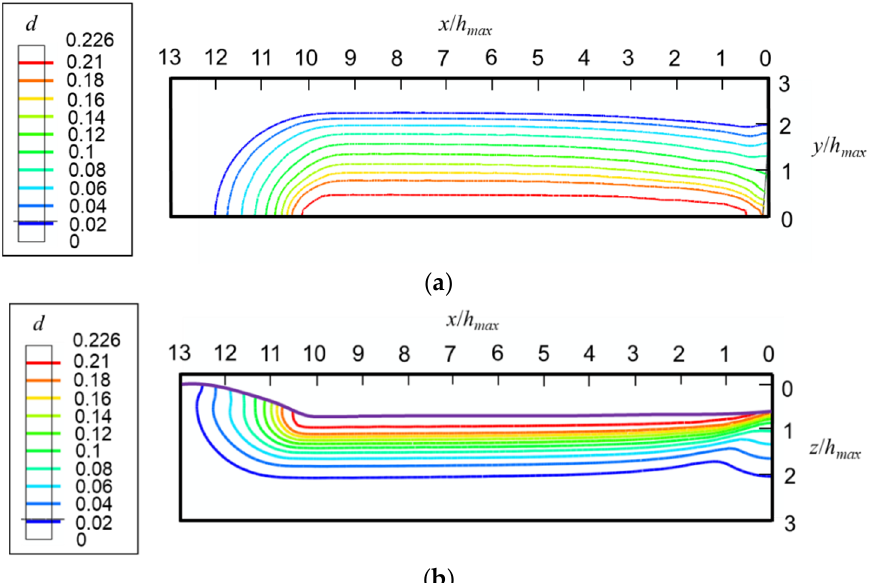
Figure 12. Contours of densification at the fully unloaded state induced by scratching with a 70.3° conical indenter in ( a ) the top surface and ( b ) xz -cross-section.